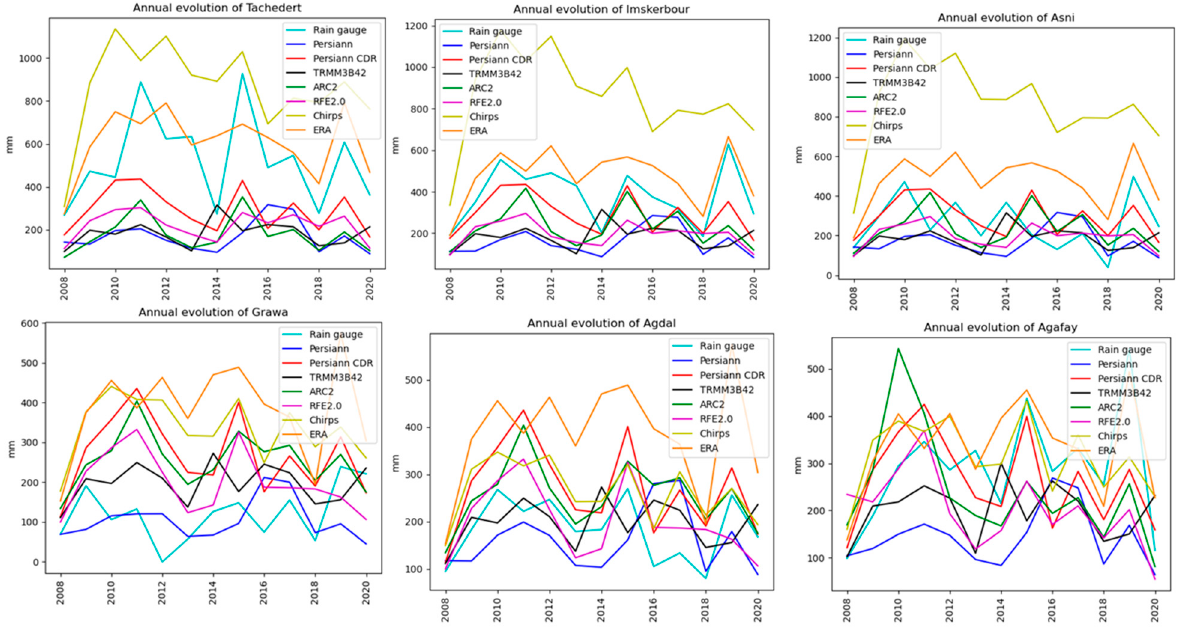
Figure 8. Temporal evolution of annual rainfall rates (mm) for each rain gauge and corresponding satellite pixels.